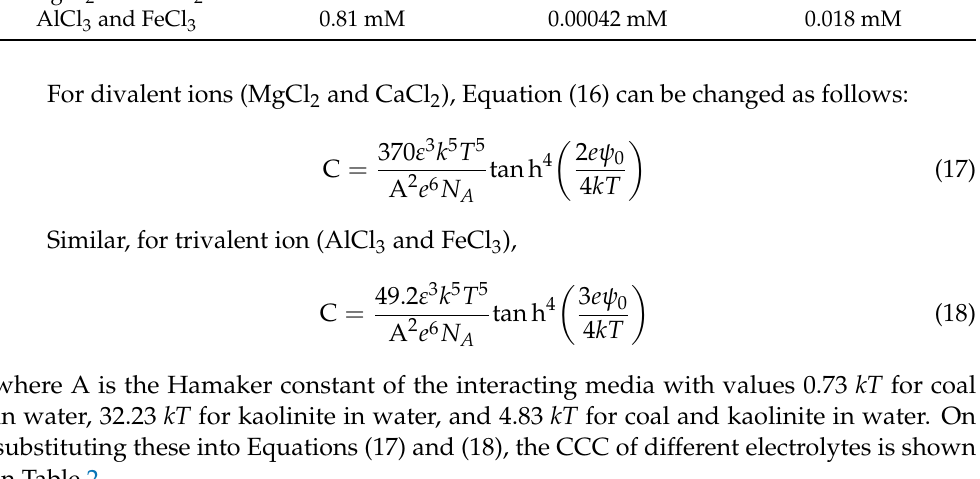
Table 2. The critical coagulation concentration of different coagulants. Coal-Coal Kaolinite-Kaolinite